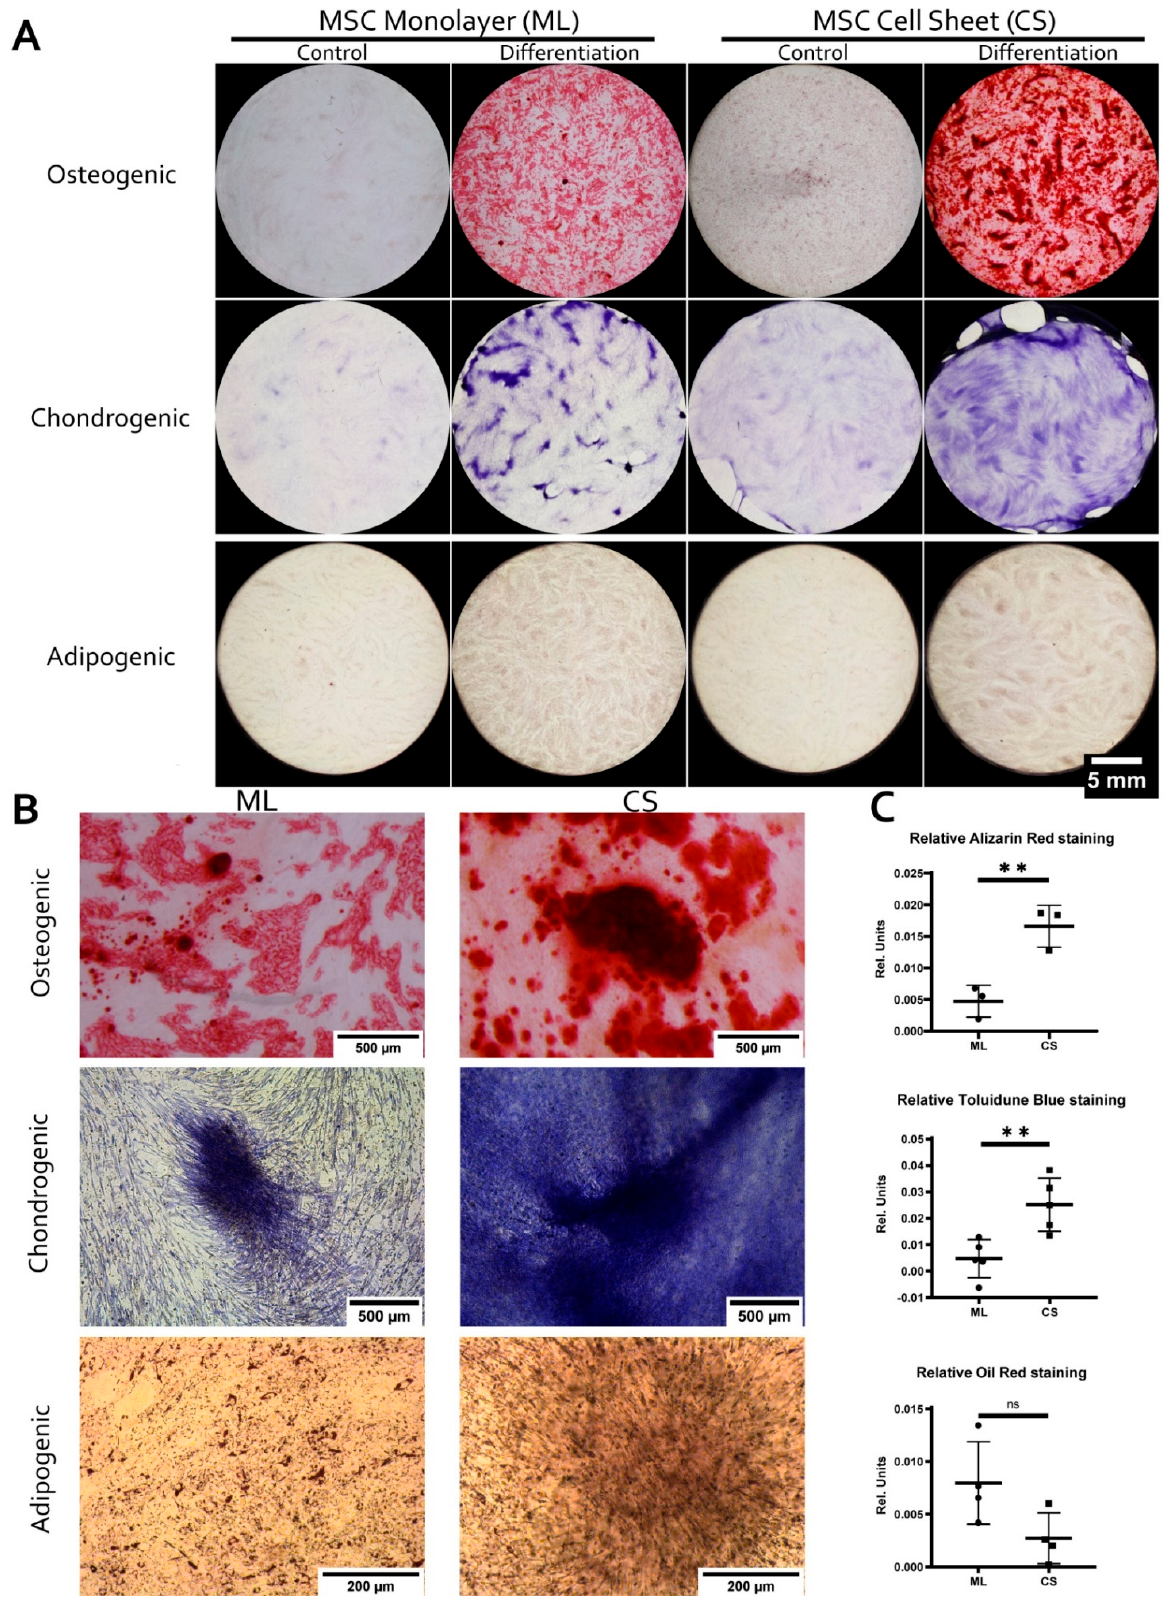
Figure 3. Analysis of MSC differentiation demonstrates a preference for condensation-dependent lineages (osteogenic and chondrogenic) in cell sheets (CS) compared to monolayer cultures. ( A ) MSC monolayer and CS cultures stained after